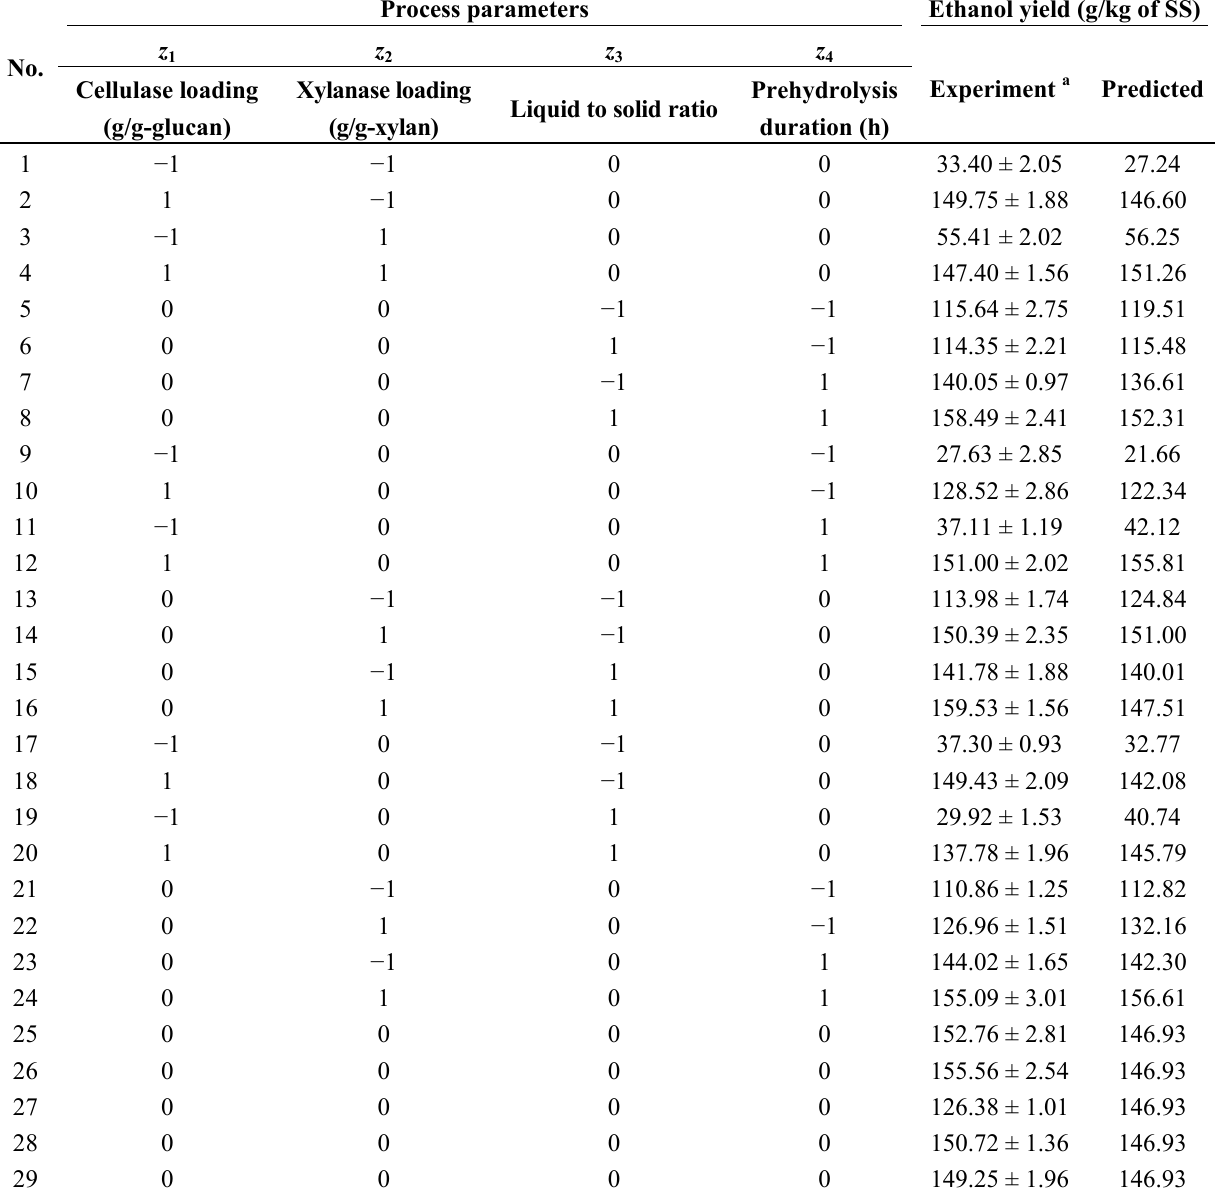
Table 1. Box-Behnken design (coded values) and experimental data for response surface methodology